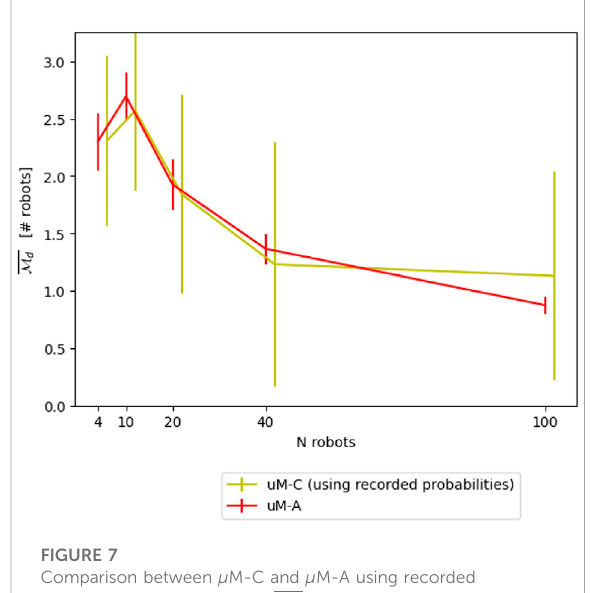
FIGURE 7 Comparison between μ M-C and μ M-A using recorded probabilities of μ M-A for the M d